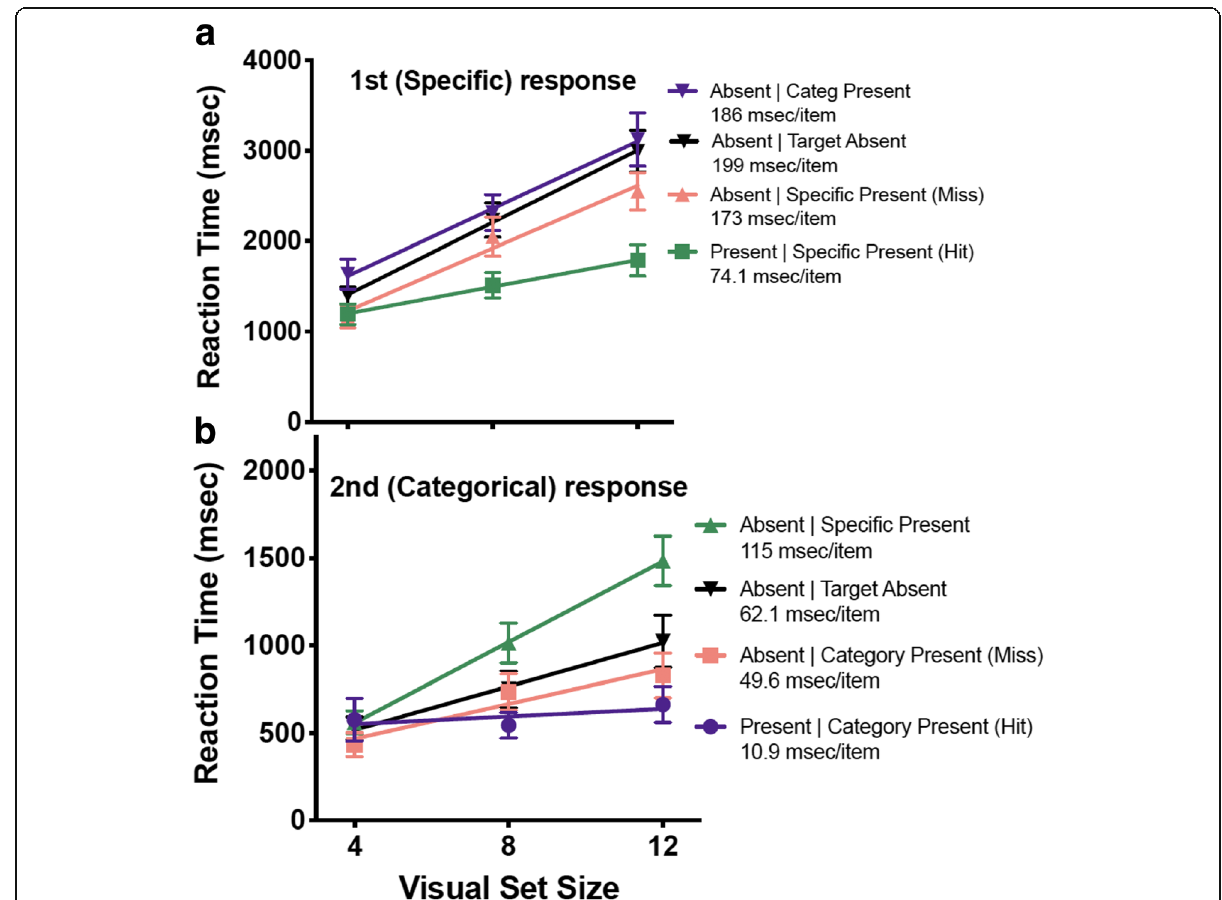
Fig. 7 a (top). Reaction times as a function of visual set size for the 1st (specific) response. b (bottom). Reaction times as a function of visual set size for the 2nd (categorical) response. Each line corresponds to a type of trial. There are two possible true-negative responses for response 1 and response 2: a trial containing no targets at all, and a trial containing a target of the other